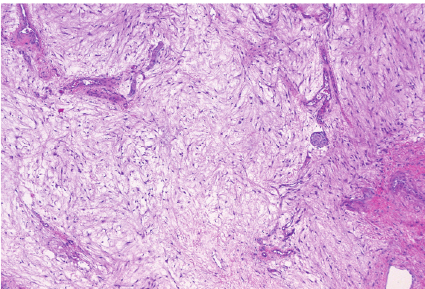
Figure 1: Tissue section from the right labial mass showing tumor composed of spindle- and stellate-shaped cells in a myxoid matrix, hematoxylin and eosin 400x.